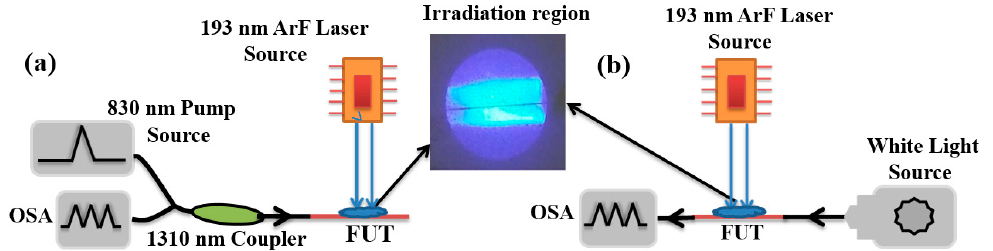
Figure 1. Irradiation effect measurement setup: ( a ) Luminescence spectra measurement system and ( b ) Transmission spectra measurement system.